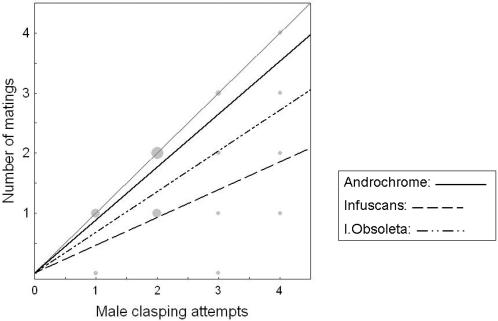
Morph-specific variation in female resistance to male mating attempts.Relationships between the number of matings (Y-axis) and the number of male clasping attempts received by each morph (X-axis). The fine dotted line marks a (hypothetical) 1∶1 slope, where every clasping attempt by a male ends in a mating. Regression lines below the 1∶1 relationship reveals morph-specific levels of female resistance towards mating attempts from males. The regression slopes differ significantly between the three female morphs (Morph * No. Male Claspings: F2,266 = 5.373, P = 0.005). Differences between androchrome females (solid regression line) and infuscans-females (dashed line) remains significant even if the morph with the lowest sample size (Infuscans obsoleta (dash-dot line)), is excluded from the data-set (F1,260 = 10.072, P = 0.002). Regression slopes of both androchrome females and infuscans-females differ significantly from unity (upper 95 % CL: 0.987 and 0.697 respectively), showing that both morphs do not accept all male mating attempts and show some degree of resistance. Sizes of the data points are proportional to the sample size at each position (range: 1–97 mean = 23.1).